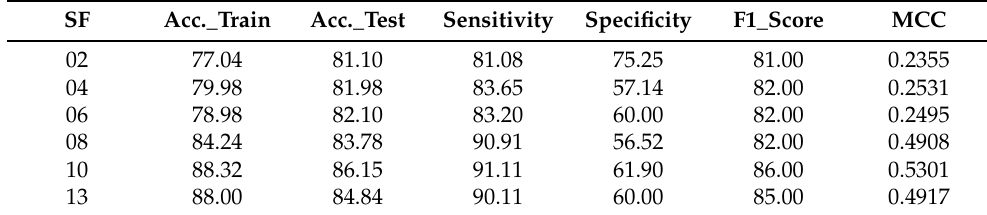
Table 5. Performance of the proposed model ( χ 2 _RF) on imbalanced